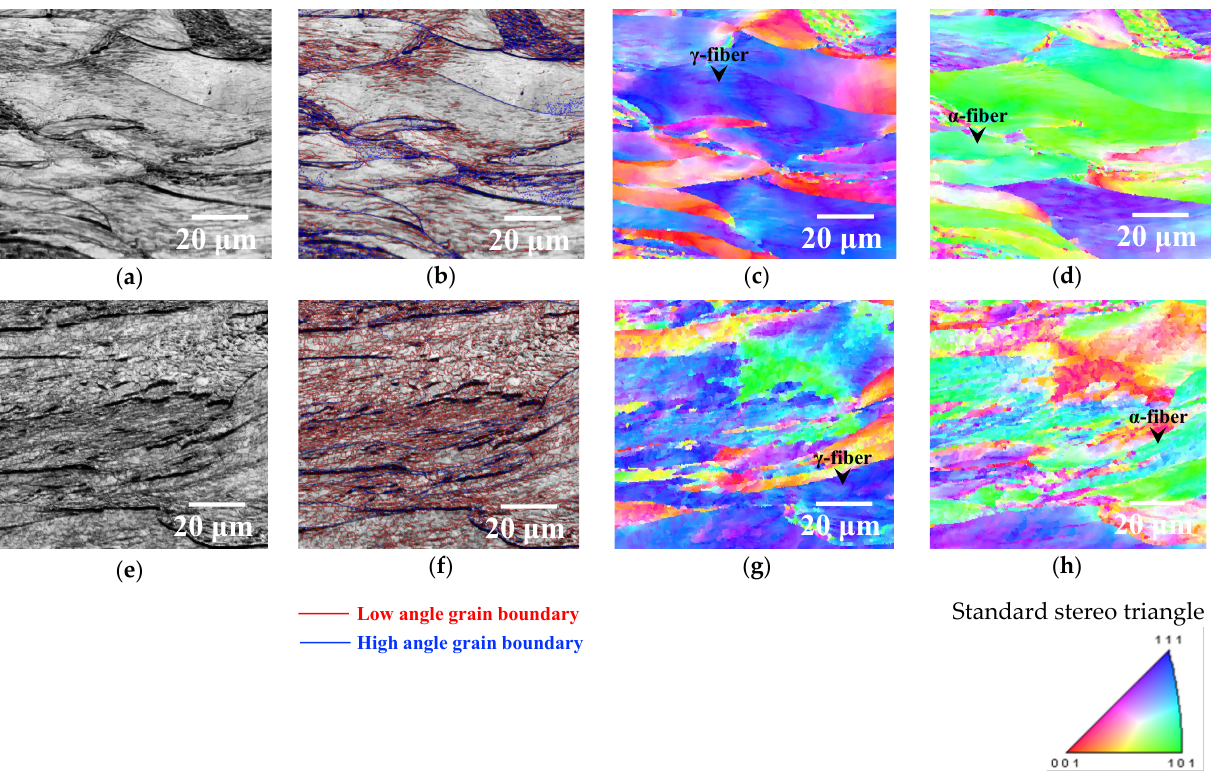
Figure 2. Image quality, grain-boundary misorientation angle, and normal direction (ND) and rolling direction (RD) orientation maps of specimens annealed at ( a – d ) 623 and ( e – h ) 673 K for 10 s.